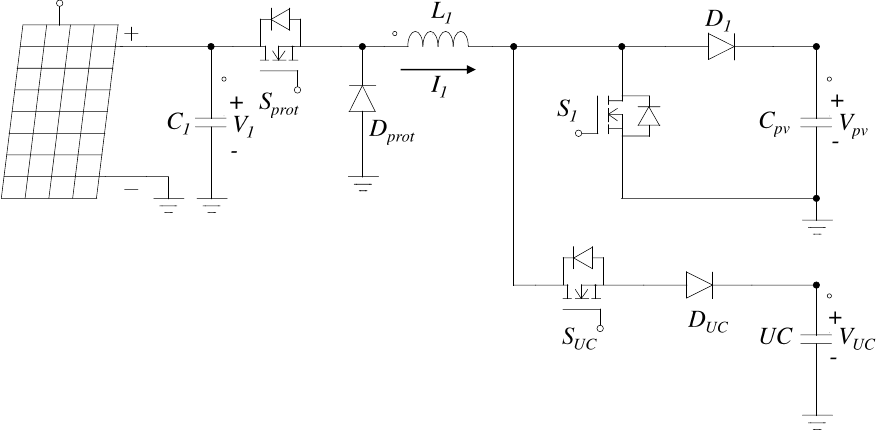
Figure 3. Converter associated with the PV.